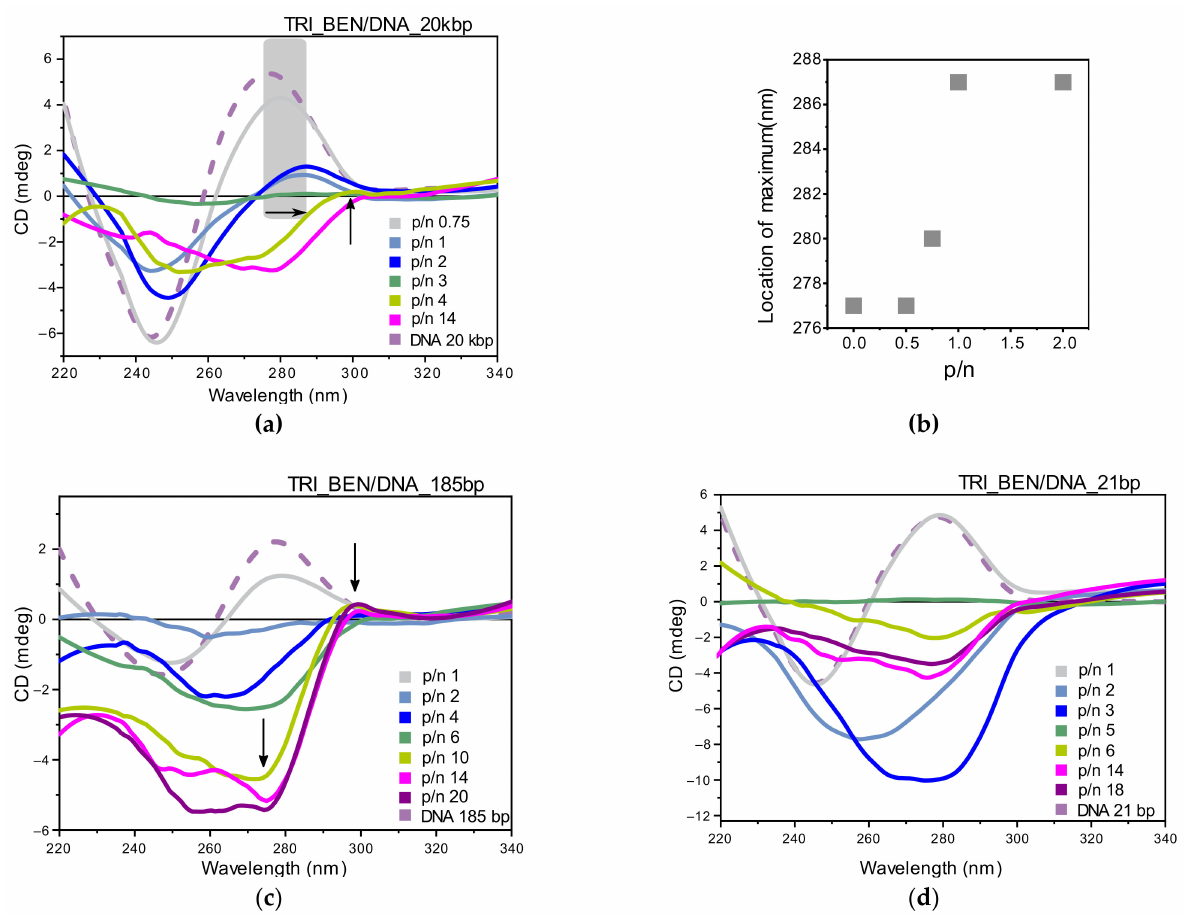
Figure 7. Circular dichroism studies of TRI_BEN surfactant with different DNAs. ( a ) CD spectra collected for TRI_BEN/DNA_20kbp systems and ( b ) corresponding shifts of positive maximum with increasing p/n ratio. ( c ) CD spectra collected for TRI_BEN/DNA_185bp systems and ( d ) CD spectra collected for TRI_BEN/DNA_21bp